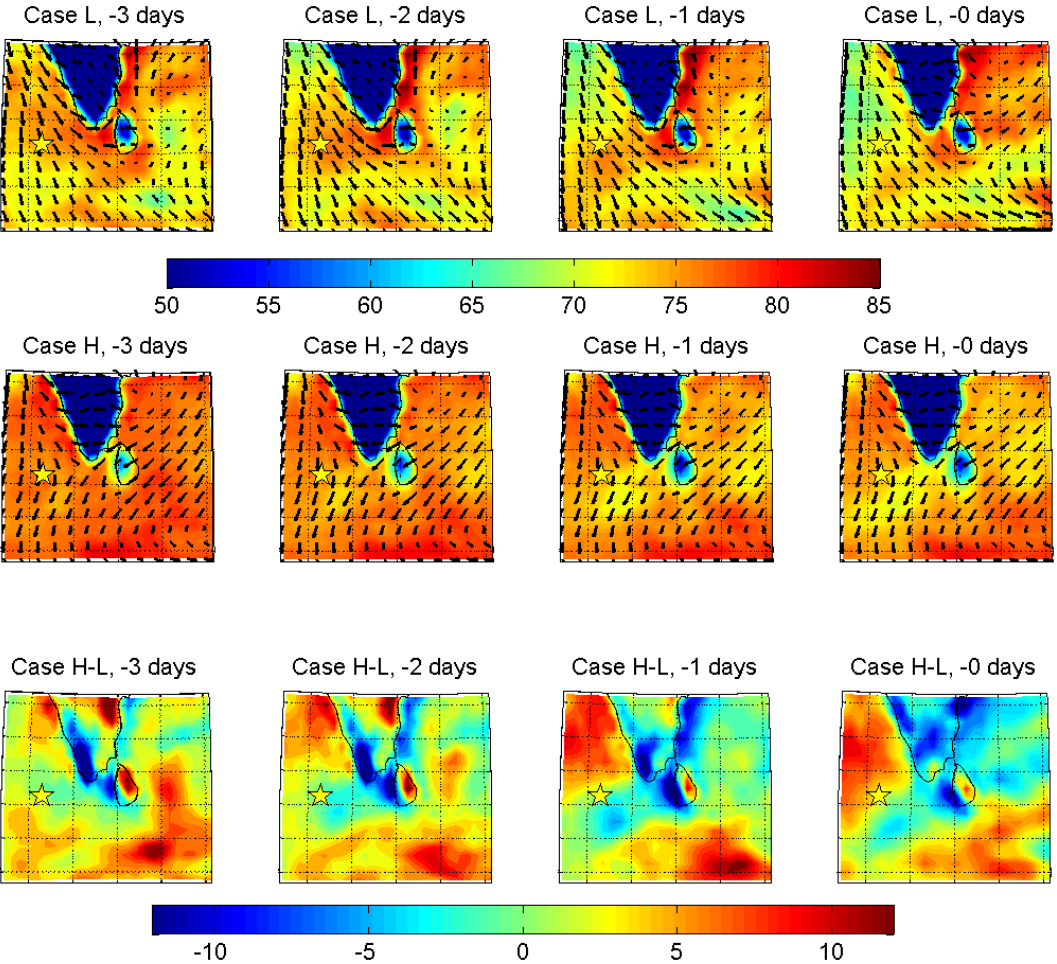
Figure A8. As in Figs. A6 and A7 but showing ECMWF 1000hPa relative humidity (%) overlaid with average winds for the preceding 3 days and the day in question – Case L, Case H, or the difference (H −